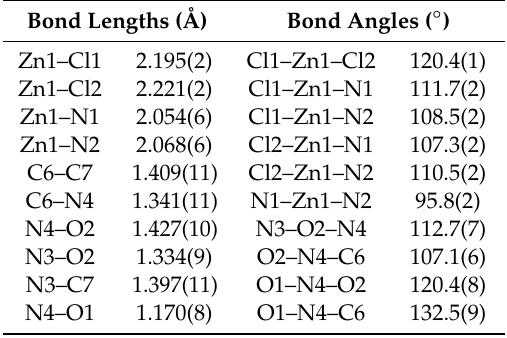
Table 3. Hydrogen bonding interactions (Å, ◦ ) in the crystal structure of [ZnCl 2 (L)] ( 1